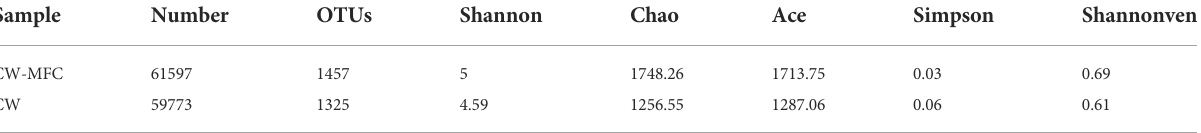
TABLE 4 Statistics of alpha diversity